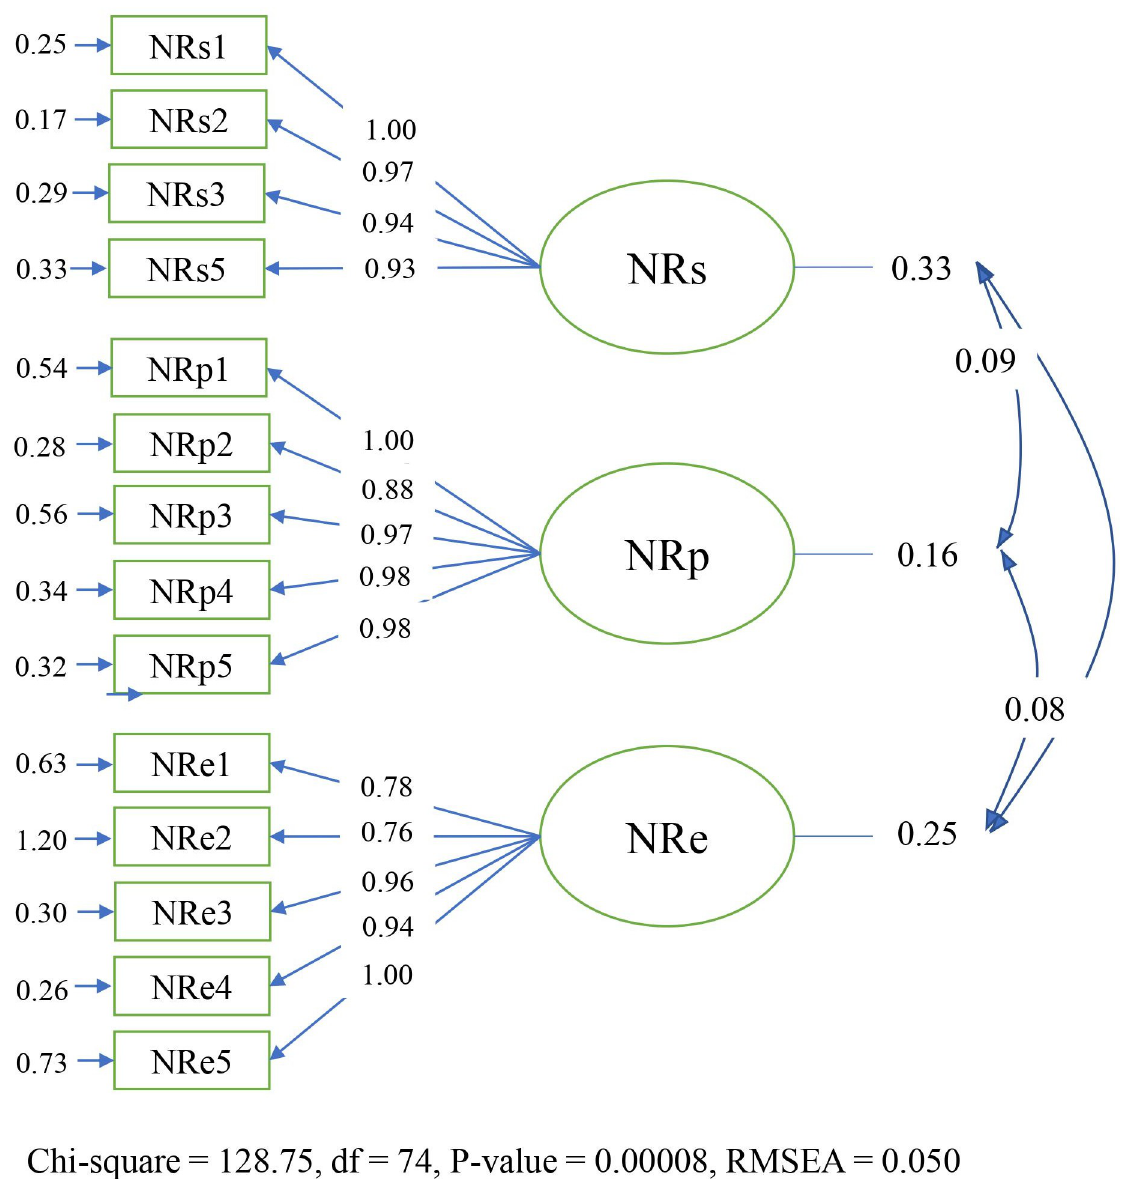
Fig 1. The Path diagram and factor loadings of